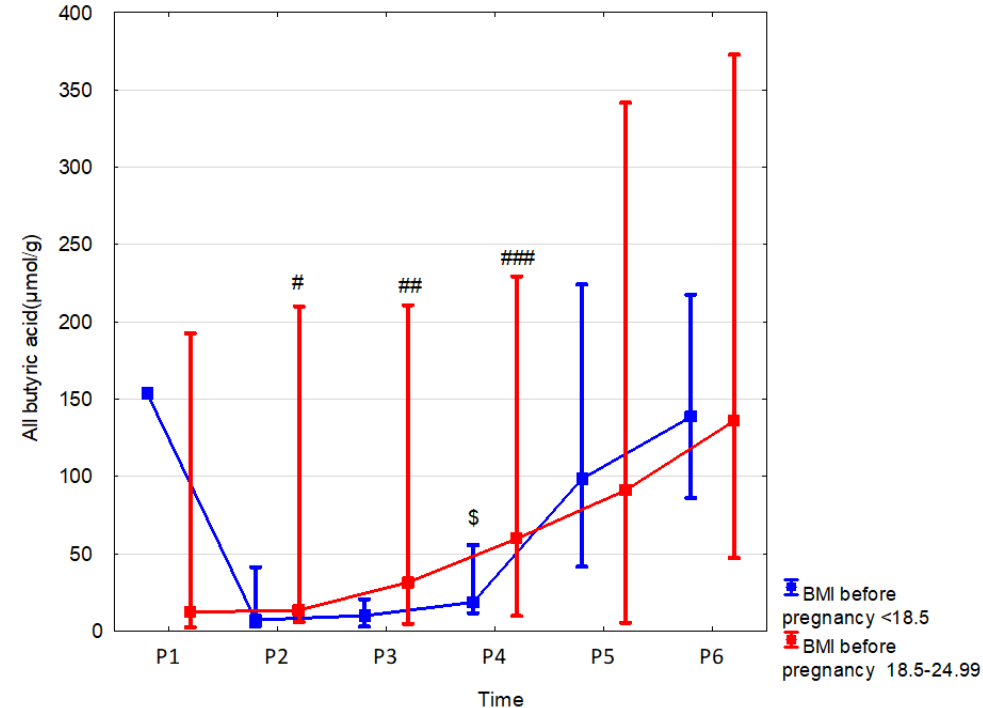
Figure 6. All butyric acid (median) in children over time according to the effects of BMI before pregnancy: BMI before pregnancy 18.5–24.99 (red line) or BMI before pregnancy < 18.5 (blue line). Legend: Error bars represent range. Wilcoxon paired tests regarding time, # (BMI before pregnancy 18.5–24.99), $ (BMI before pregnancy < 18.5): # p < 0.05 P2 vs. P5 and P6; ## p < 0.05 P3 vs. P6; ###, $: